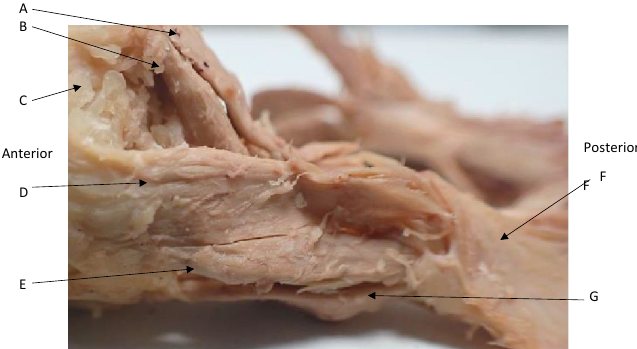
Figure 6. Dual heads of the lateral rectus. Upper head (D) and lower head (E). (A) Superior rectus, (B) Levator Palpebrae superioris, (C) eye, (F) common tendinous origin, (G) Inferior Rectus.